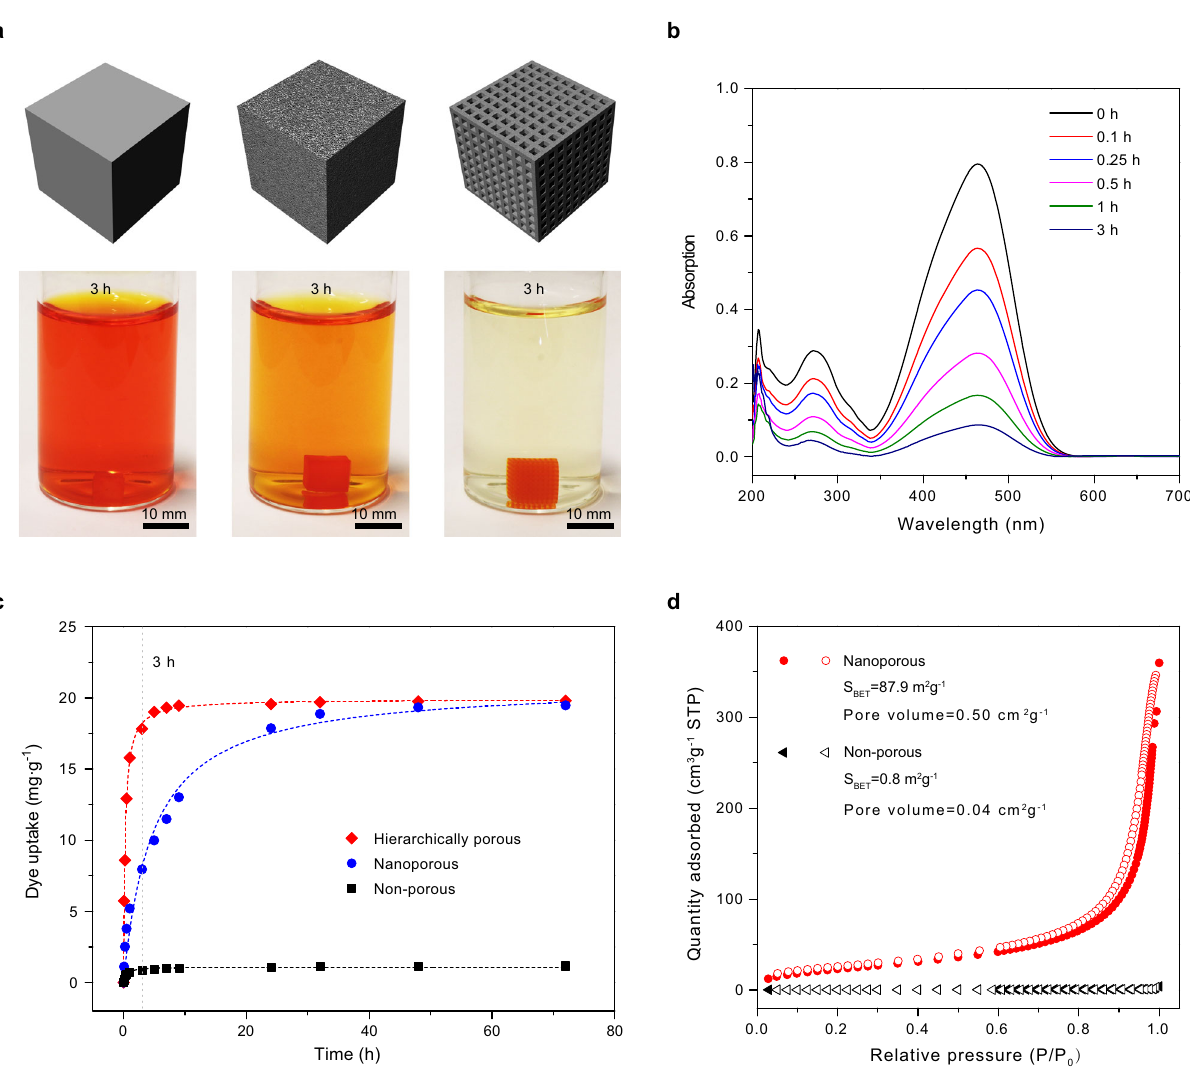
Fig. 4 Adsorption of aqueous methyl orange by 3D printed adsorbents. a Photographs of 20 mL methyl orange solutions (100 ppm) after incubating 20 mg of the non-porous, nanoporous, and hierarchically porous adsorbents in the solution for 3 h. b Time-dependent UV – Vis spectra of the methyl orange solution in the presence of the hierarchically porous adsorbent (analytes were diluted by a factor of 10). c Time-dependent methyl orange uptake by the non-porous, nanoporous, and hierarchically porous adsorbents in 72 h, with pseudo-second order kinetic modeling (dash lines). d N 2 adsorption (solid) and desorption (hollow) isotherms of the inherently nanoporous polymer and the non-porous polymer. Representative of three independent experiments ( N = scaffolds for supporting cell adhesion and proliferation, Hep G2 cells (1 × 10 6 cells per mL) were seeded on the inherently nanoporous and non-porous 3D scaffolds, and were analyzed by fl uorescence confocal microscopy 1, 2, and 4 days post-seeding. The surface coverage of the scaffolds during the culture period was quanti fi ed by analyzing the integrated 3D images. Results show that the area covered by live cells (Calcein-positive) on the inherently nanoporous 3D scaffold (27.0%) was 4 times higher than that of the non-porous 3D scaffold (6.1%) after 1 day (Fig. 5b – d), indicating favored initial cell adhesion. The cell coverage on the inherently nanoporous 3D scaffold gradually increased with the extended incubation period and remained 3- fold higher than that of the non-porous 3D scaffold (Fig. 5b – d).